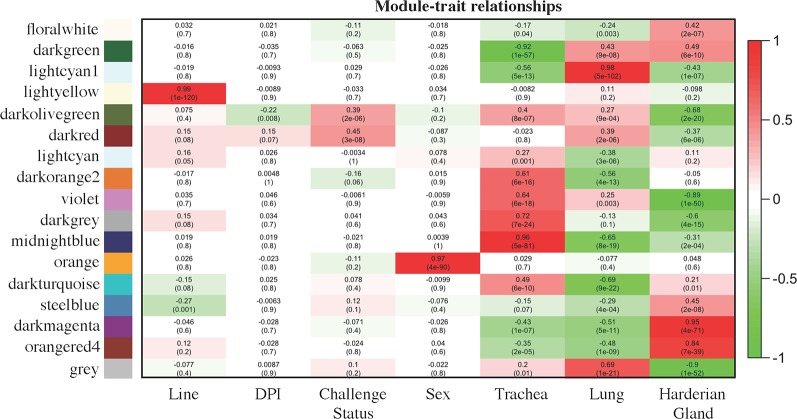
Module–trait relationships calculated by WGCNA. Factors of interest (x-axis) were correlated to each module (y-axis). The first value within each square is the correlation and the second value in parenthesis is the p value of the association. The more positively correlated the module and the factor, the more red the square; the more negatively correlated, the more green. Coding for the factors was as follows: Line [Fayoumi (1), Leghorn (0)], days post-infection [dpi; 2 dpi (0), 6 dpi (1), 10 dpi (2)], NDV [challenged (1), non-challenged (0)], sex [male (1), female (0)], Trachea [Trachea (1), Lung (0), Harderian gland (0)], Lung [Trachea (0), Lung (1), Harderian gland (0)], and Harderian gland [Trachea (0), Lung (0), Harderian gland (1)].